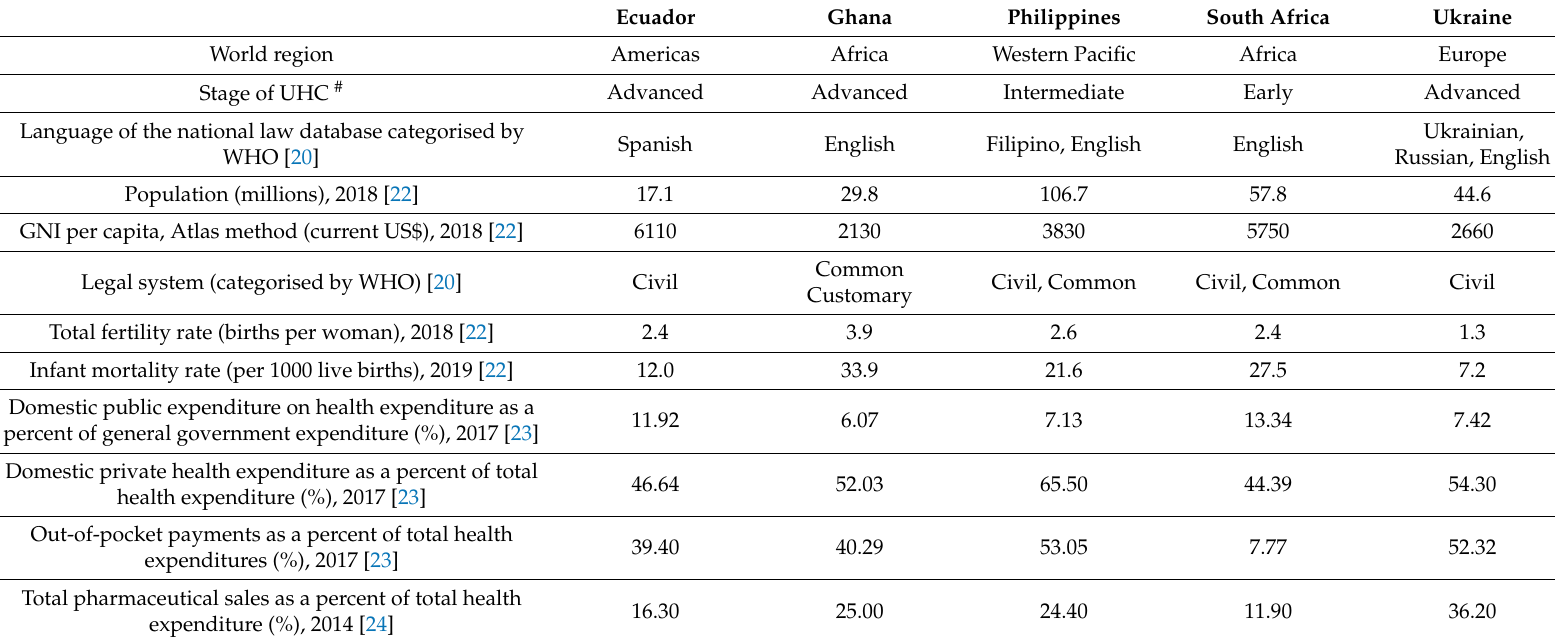
Table 1. Overview of characteristics of the five middle-income